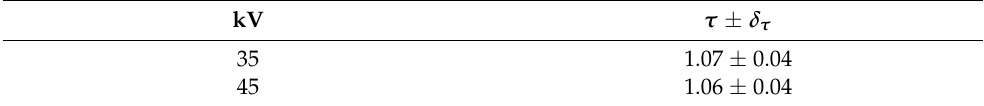
Table 3. The air-to-water dose conversion factor ( τ ).